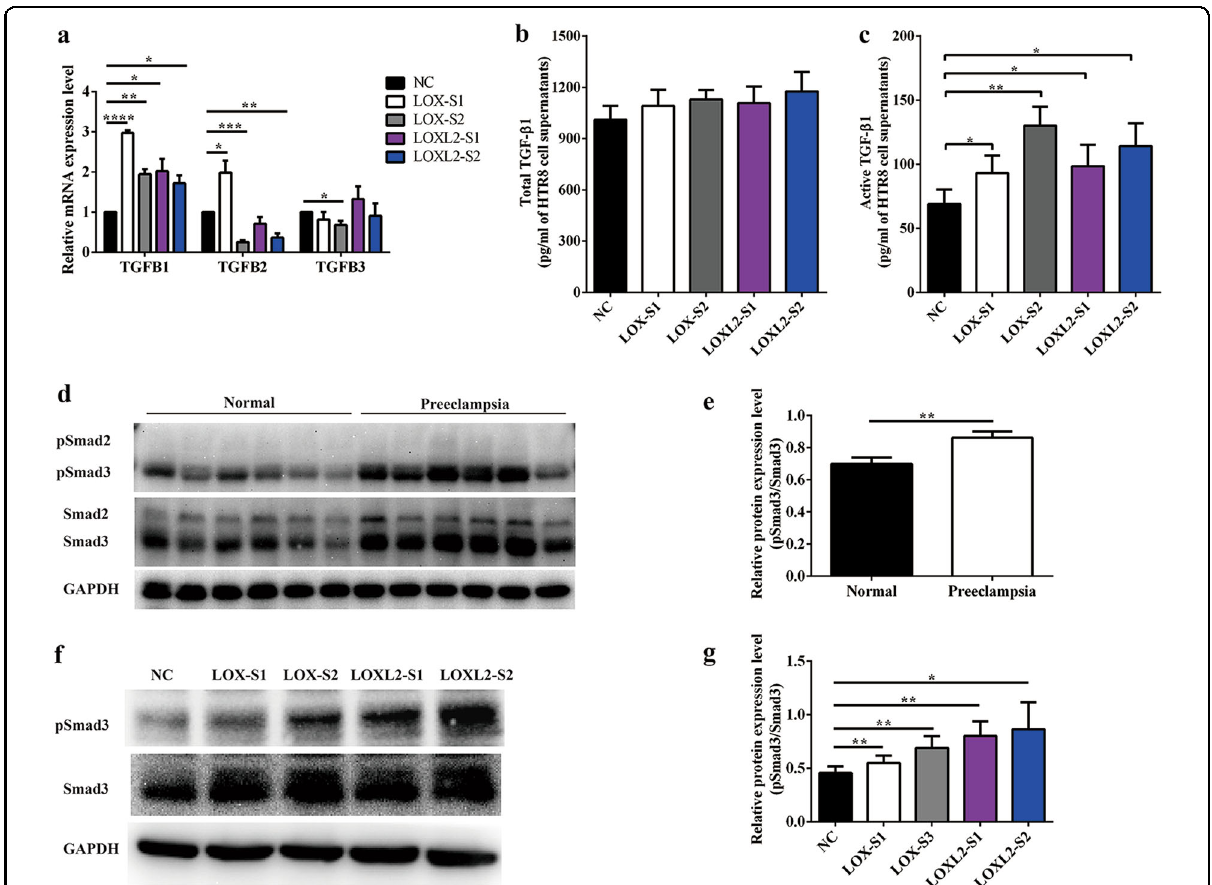
Fig. 4 TGF- β 1/Smad3 signaling was activated in LOX - or LOXL2 -downregulated trophoblast cells. a mRNA expression of TGFB1 , TGFB2 , and TGFB3 was determined by quantitative reverse-transcription PCR. b , c Total and active transforming growth factor- β 1 (TGF- β 1) protein levels in culture supernatants from HTR-8/SVneo cells transfected with small interfering RNA (siRNA) were measured by enyme-linked immunosorbent assay. d Western blotting and e quanti fi cation analysis of pSmad2/3 and Smad2/3 in placentas from normal pregnant women and preeclampsia patients. f Western blotting and g quanti fi cation analysis of pSmad2/3 and Smad2/3 in HTR-8/SVneo cells transfected with siRNA. Statistical data were analyzed by Student ’ s t -test. Data are presented as the means ± SEM of three independent experiments. * P < 0.05; ** P < 0.01; *** P < 0.001; and **** P <